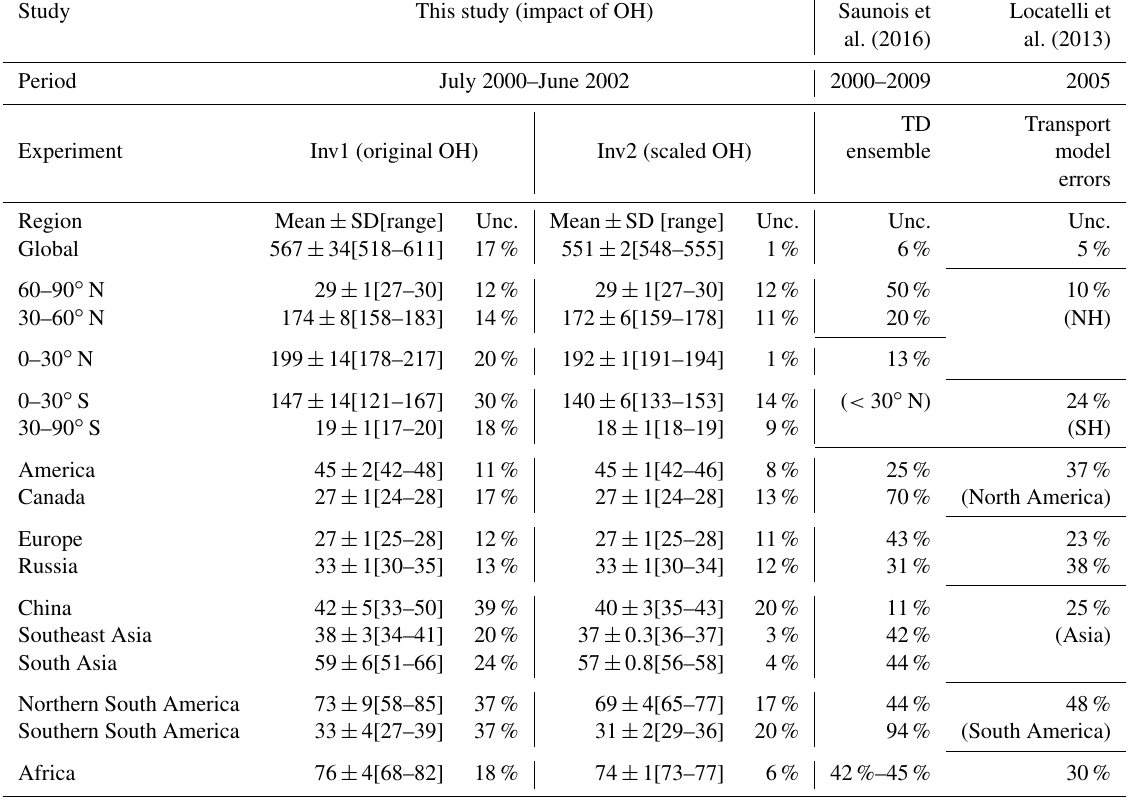
Table 3. Global, latitudinal, and regional CH 4 emissions (Tgyr − 1 ; mean ± SD and the min–max range of the inversions) calculated by Inv1 and Inv2 during the early 2000s (July 2000–June 2002; Tgyr − 1 , excluding MOCAGE and SOCOL3). The uncertainties (unc. = (max– min) / multi-inversion mean) arising from using different OH fields are compared with the uncertainties in CH 4 emissions given by Saunois et al. (2016) and Locatelli et al. (2013).